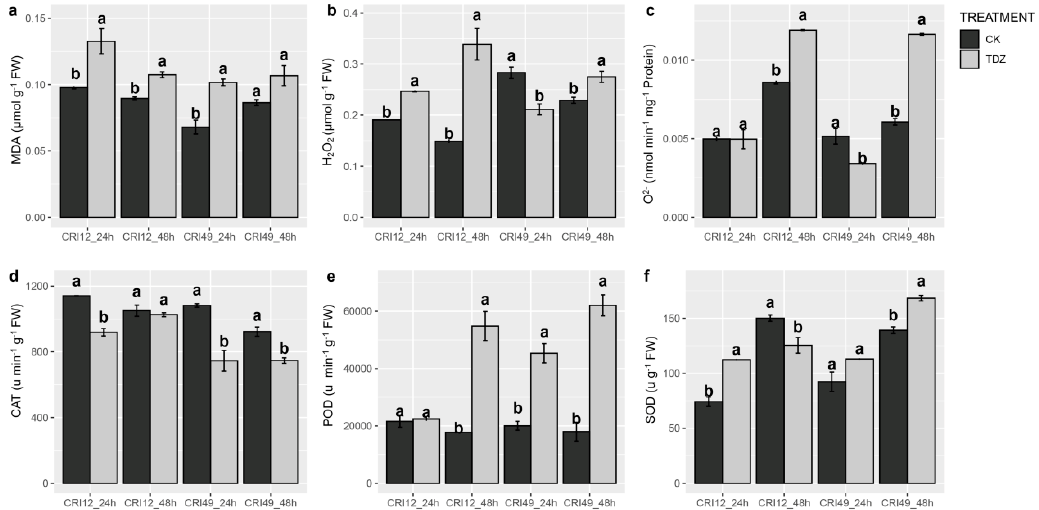
Figure 2. Effect of TDZ on malondialdehyde (MDA), H 2 O 2 and O 2 − content, and the activities of antioxidant enzymes in cotton leaves. ( a ) MDA content; ( b ) H 2 O 2 content; ( c ) O 2 − ptoduction rate; ( d ) CAT enzyme activity; ( e ) POD enzyme activity; ( f ) SOD enzyme activity. CK and TDZ represent control (water treatment) and 100 mg L-1 TDZ treatment, respectively. Values not sharing a common letter within the same column are significantly different ( p < 0.05) according to Duncan’s test using SAS software.